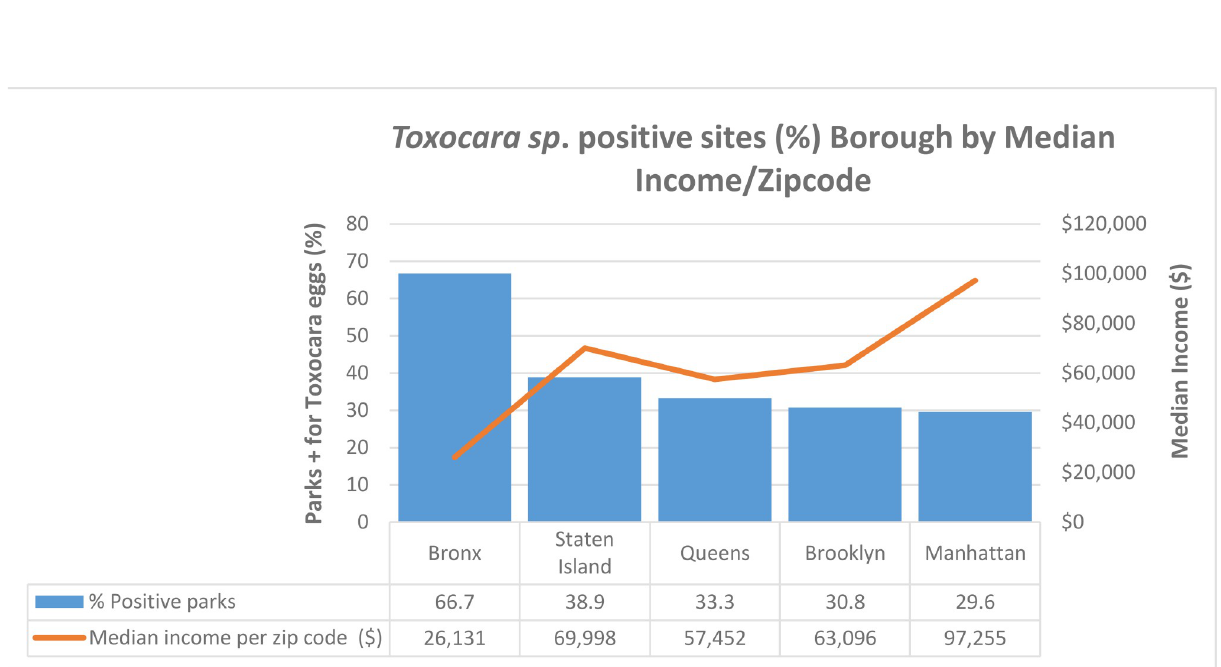
Fig 4. Association of positive Toxocara results with the median income of residents living in the ZIP codes of sampled sites. The line represents the median income of families living in the zip code where Toxocara testing was performed. Results aggregated by borough. (Spearman r = -0.7, p = 0.233).